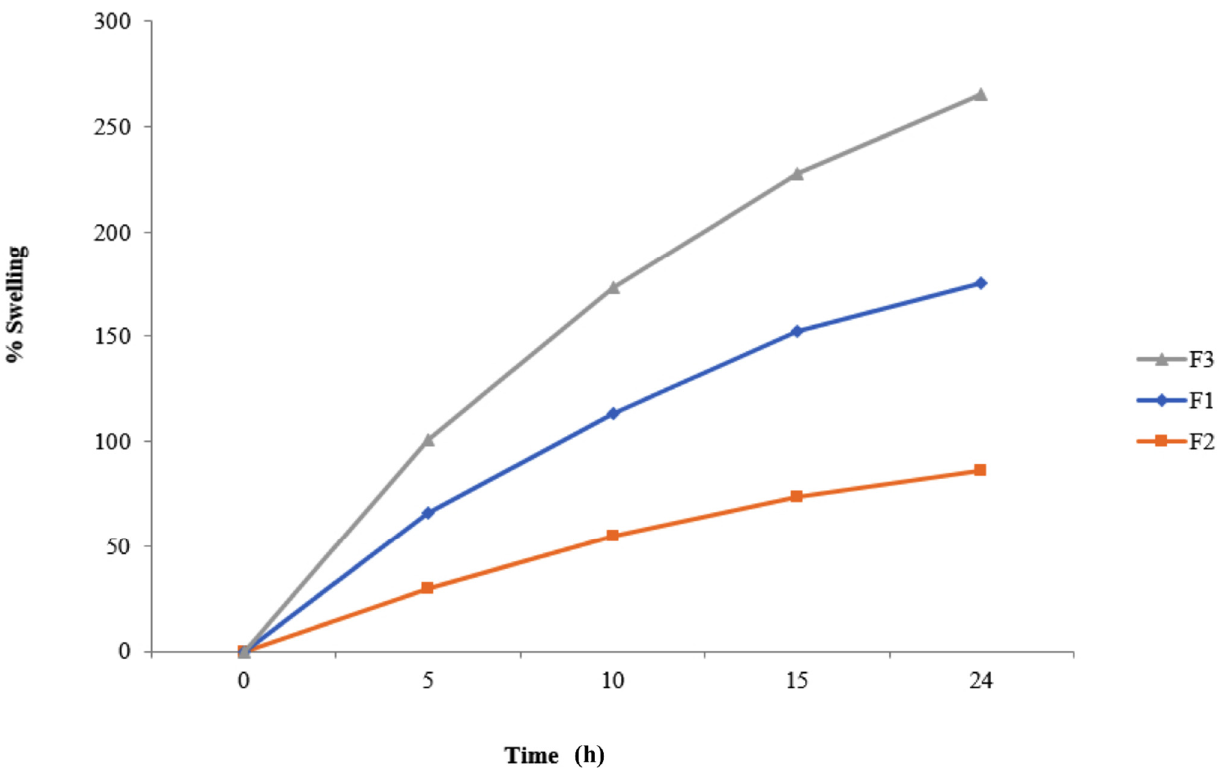
Figure 3. Graphical representation of the swelling behavior of F1, F2, and F3 formulations .